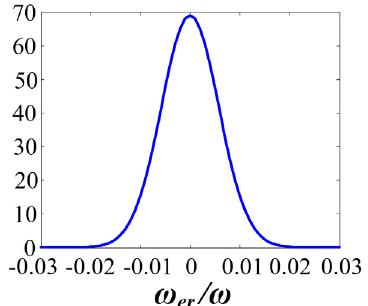
Figure 9. Probability density of the relative error caused by the rotational radius error.